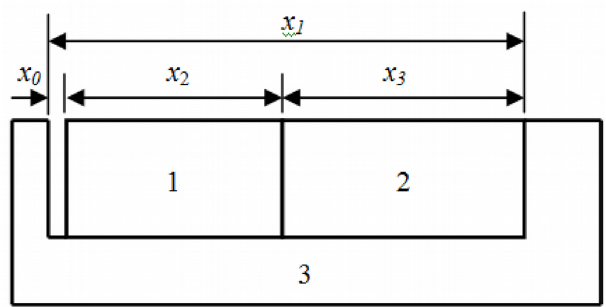
Figure 2. The assembly drawing